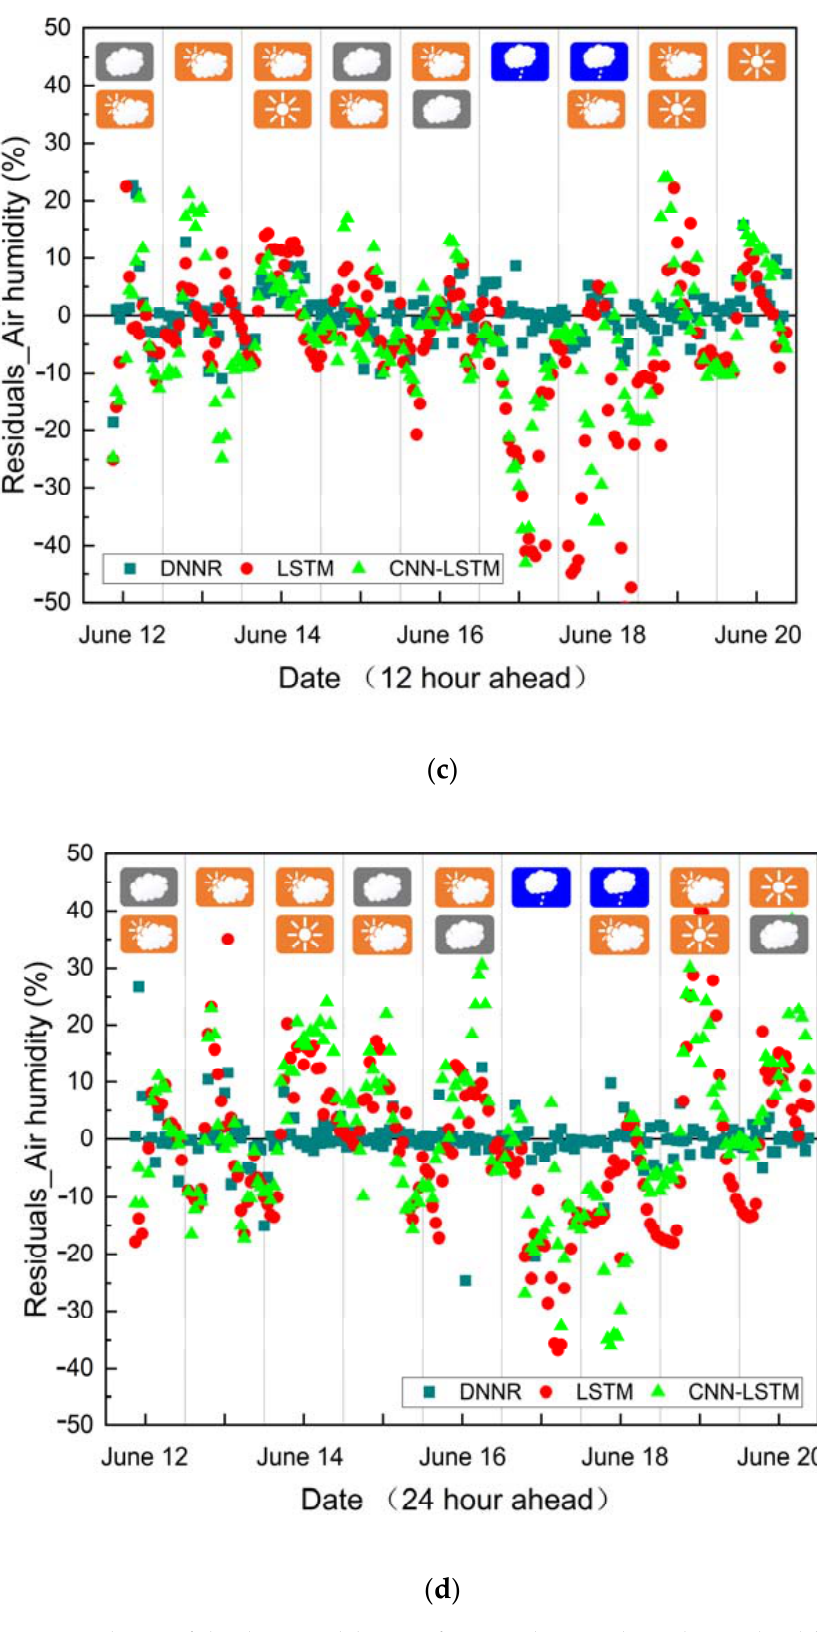
forecast time points are within [ − 5, 10], [ − 5, 7], [ − 10, 12] and [ − 7, 16] °C, respectively. The errors in the predictions of the LSTM model at four forecast time points are within [ − 7, 9], [ − 8, 6], [ − 12, 10] and [ − 11, 13] °C, respectively. The errors in the predictions of the CNN ‐ LSTM model predictions at four forecast time points are within [ − 10, 8], [ − 7, 7], [ − 12, 15]